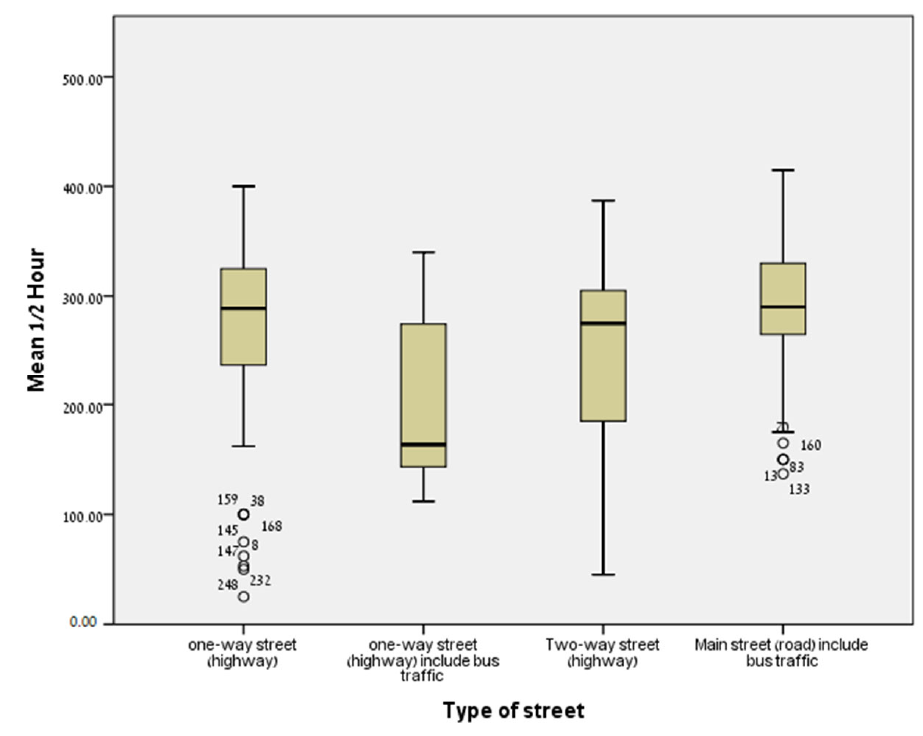
Figure 3. Distribution of NOx concentrations at the participants’ residential addresses by type of street (box-plot diagrams). Table 2. Multivariate logistic regression for the prediction of preeclampsia by joint air pollution and noise exposure.